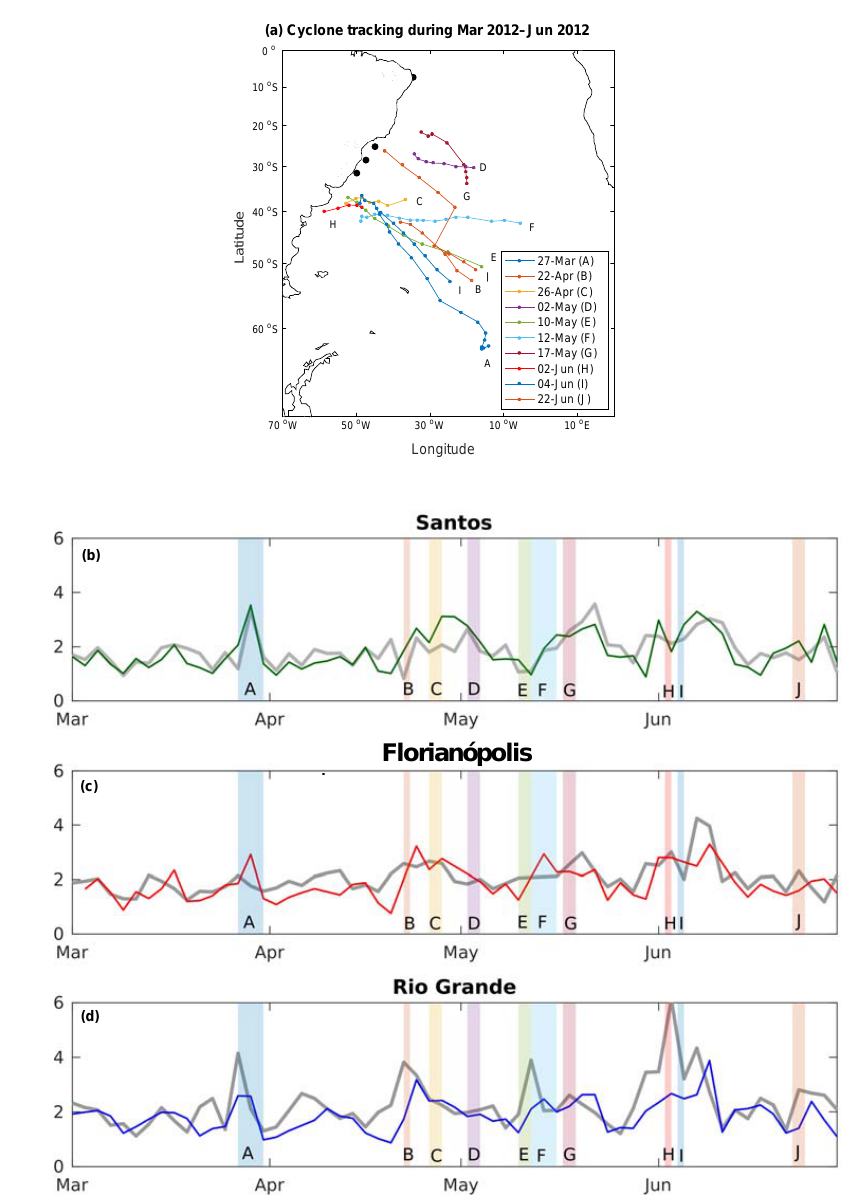
Figure 5. (a) Extratropical cyclone tracking in the South Atlantic Ocean between March and June 2012. Buoy stations are marked in black. Initial dates for cyclone occurrences are indicated and each case has a letter assigned (A–J). (b–d) Time series from linearly interpolated buoy stations (gray) and the nearest correspondent gridded LOS for Santos (green, b ), Florianópolis (red, c ) and Rio Grande (blue, d ). Extratropical cyclone occurrences shown in (a) are marked with letters